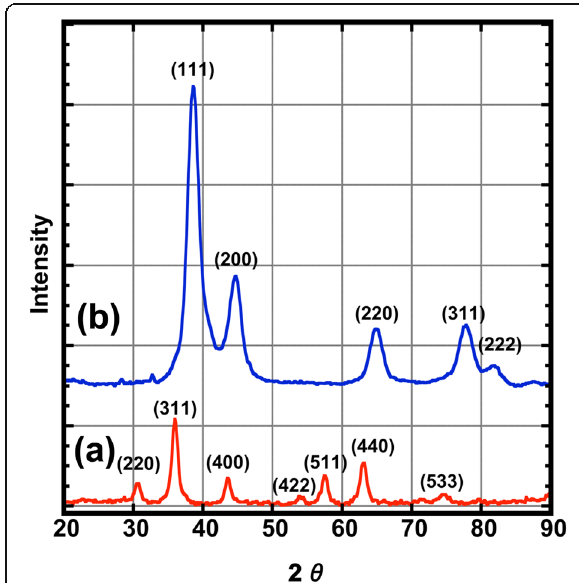
Fig. 2 XRD pattern of for nanoparticles, ( a ) CoFe 2 O 4 (red line) and ( b )